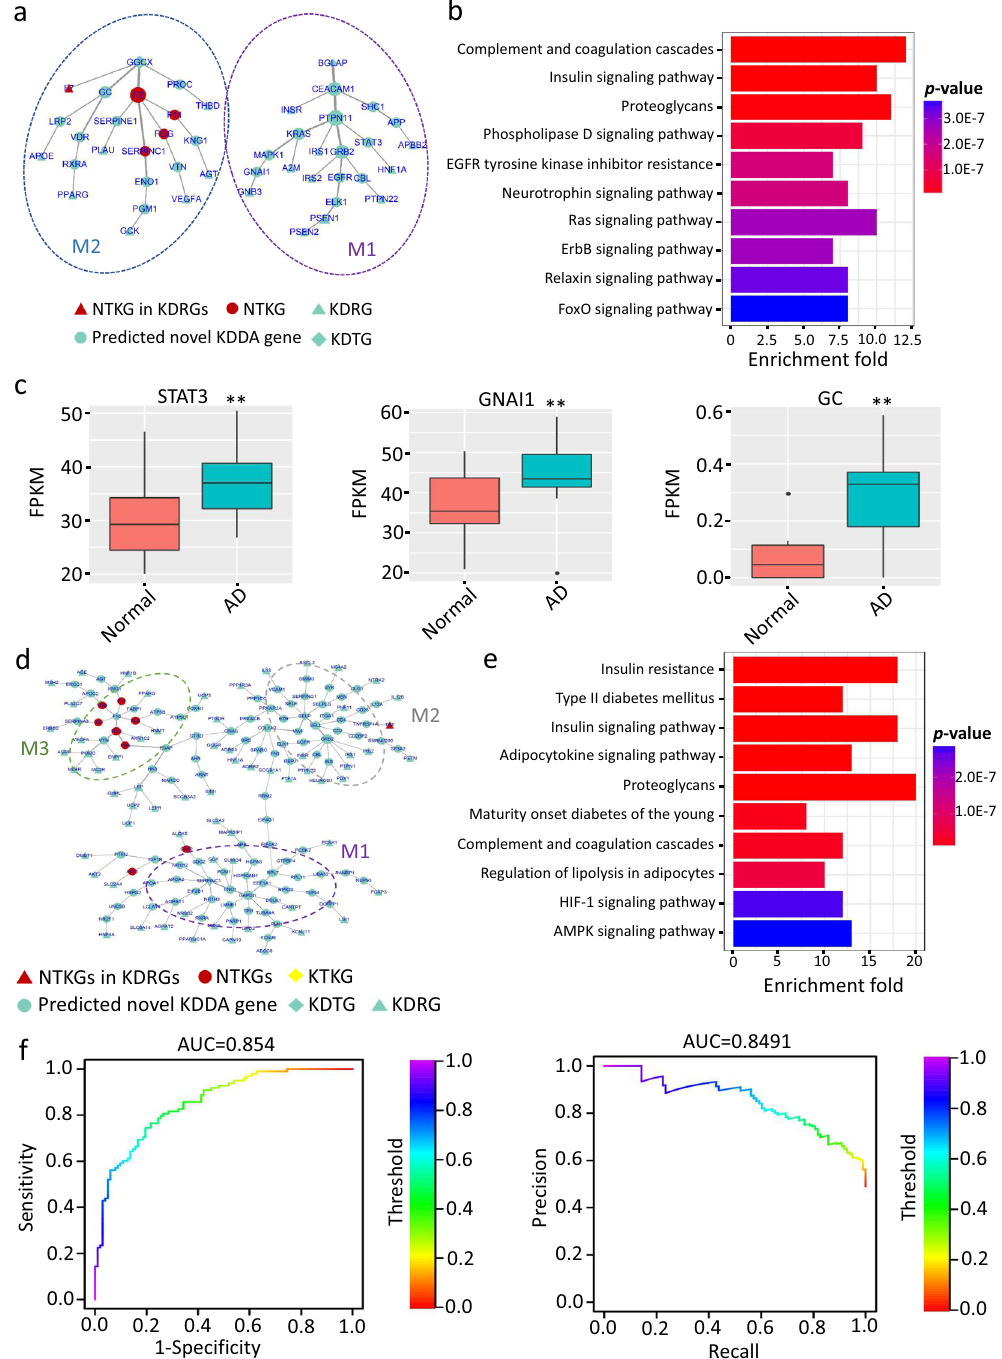
Fig. 3 Mechanistic relevance of KDDANet prediction results. a KDDANet resulting subnetwork mediating phylloquinone (DB01022)- Alzheimer ’ s disease (AD, 104300) association. b Top ten enriched KEGG terms of subnetwork genes mediating phylloquinone-AD association. c Expression level of STAT3, GNAI1, and GC in normal individuals and AD patients, ** p value < 0.01, calculated by Mann – Whitney U test. d KDDANet resulting subnetwork for heparin (DB01109)-obesity (601665) association. e Top ten enriched KEGG terms of subnetwork genes mediating heparin-obesity association. f ROC and PR curves of KDDANet gene subnetwork mediating heparin-obesity association. In the subnetworks, the size of a gene node was proportional to its network degree; The thickness of a network edge was proportional to its fl ow amount. FPKM Fragments Per Kilobase Of Exon Per Million Fragments genes of sotalol were included in this subnetwork. Meanwhile, this sotalol-prostate cancer association, KDDANet predicted a subnet- subnetwork also captured 12 prostate cancer-related genes with a work consisting of 31 genes and 28 links (Fig. 4a). By applying MCL novel NTKG of PRKACA. The top ten enriched KEGG terms of this with default parameters, this subnetwork was further decomposed subnetwork were showed in Fig. 4b. Among these, PI3K-Akt into three gene modules, M1, M2, and M3. All three known target